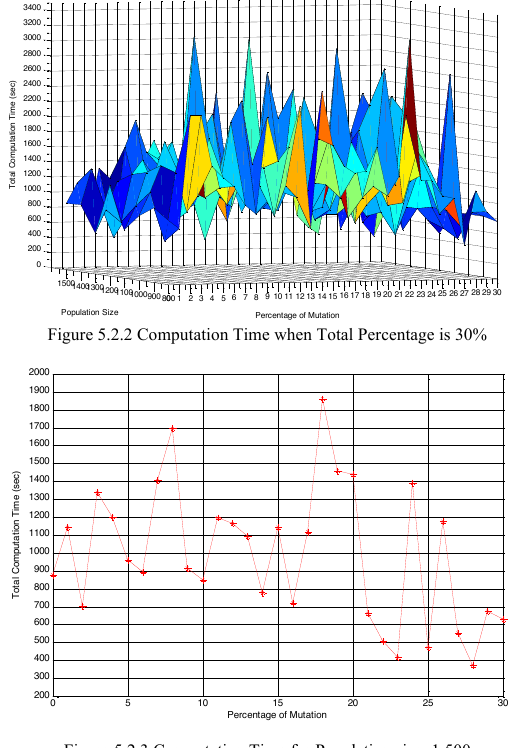
Figure 5.2.3 Computation Time for Population size, 1,500 Figure 5.2 Total Percentage of Mutation and Crossover is 30% (Mutation over